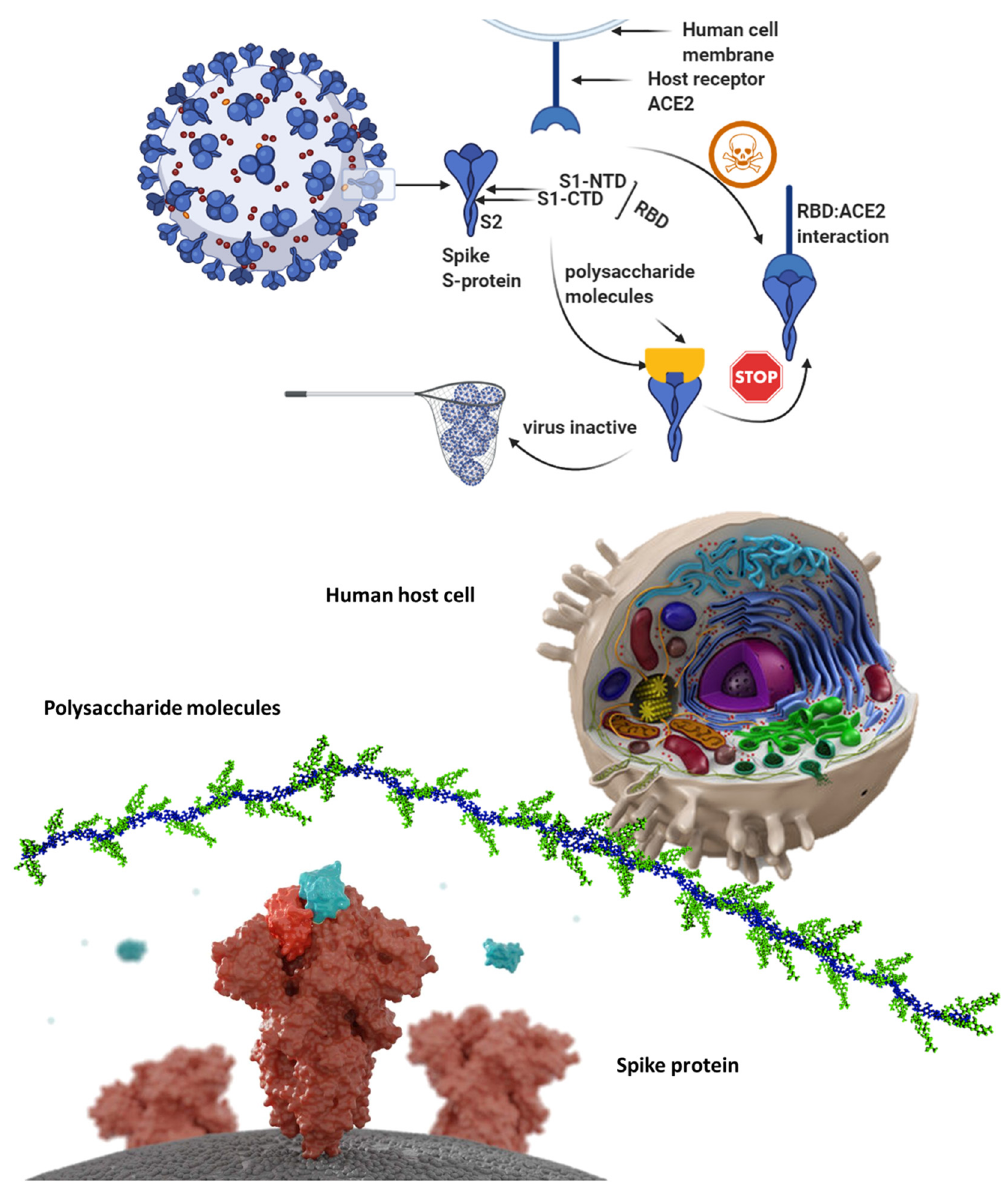
Figure 2: ( a ) The coronavirus has a large number of spike glycoproteins ( S - protein ) . S - protein exists in trimeric form, having an RBD domain unit in each subunit ( S1 and S2 ) that binds to the ( ACE2 ) receptor on the human cell membrane. The RBD - ACE2 interaction occurs in a part of the cell membrane of the heart, kidneys, lungs, and intestinal epithelium. As mentioned above, the virus spike protein/receptor pairing is a key to infecting a new host cell by RBD - AEC2 interaction. The angiotensin - converting enzyme 2 ( ACE2 ) is a mono - carboxypeptidase that hydrolyses angiotensin II. This means ACE2 is negatively charged [ 31,32 ] . So, if we used polyanionic polysaccharides, they could prevent RBD - AEC2 interaction. Many polyanionic polysaccharide e ff orts neutralize antibodies of RBD to prevent viral entry and fusion with host cells. ( b ) This model shows the surface SARS - CoV - 2 virus has spike proteins that infect the human host cells; the polysaccharide molecules ( especially anionic ) shield the folded peptide inside. The green site is charged hydrophilic regions, and the blue site is hydrophobic regions. The two regions help polysaccharides to attach to the protein of virus ’ s human cells that would be e ff ective to prevent RBD - ACE2